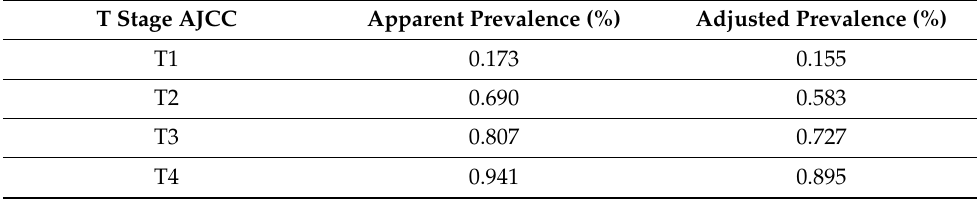
Figure 2. Probability of failure to identify metastatic nodes (false negative) in the pathological evaluation process. The probability was divided into four groups based on T stage , from T1 to T4, to examine a patient with a truly positive lymph node status. Table 3. Both apparent and adjusted prevalence results from each T stage